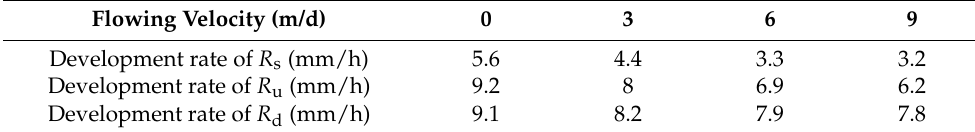
Table 3. The development rate of frozen curtain thickness. Flowing Velocity (m/d) 0 Development rate of R s